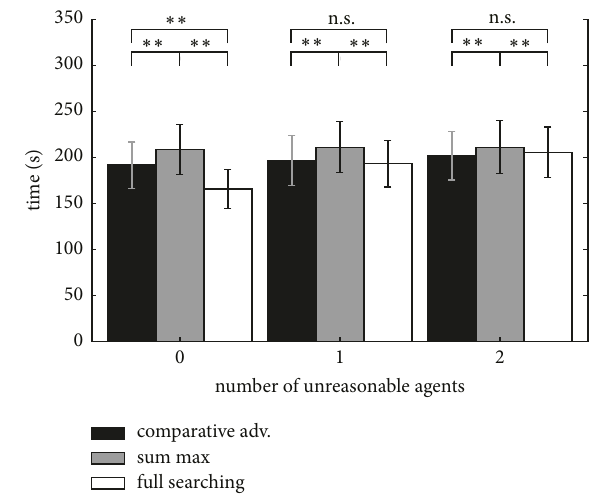
Figure 26: Makespan in situations where there is an unreasonable agent (three robots). ∗∗ 𝑝 < .01 , ∗ 𝑝 < .05 , and + 𝑝 < .1 . A significant 𝑝 value indicates that a significant difference in prescribing exists between the conditions. The lower 𝑝 value indicates a strong significant difference. n.s. means no significant difference between the